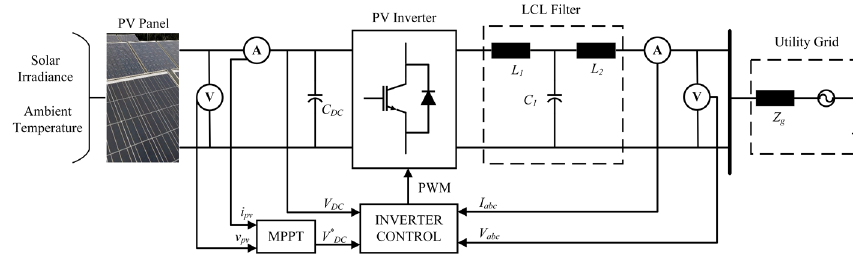
Figure 4. A 3 kW grid-connected PV inverter.